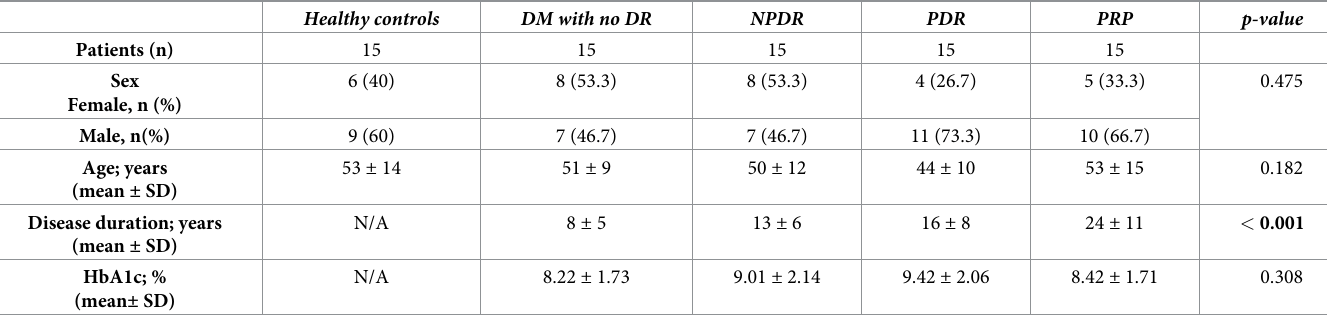
Table 1. Demographic and disease-related patient characteristics.